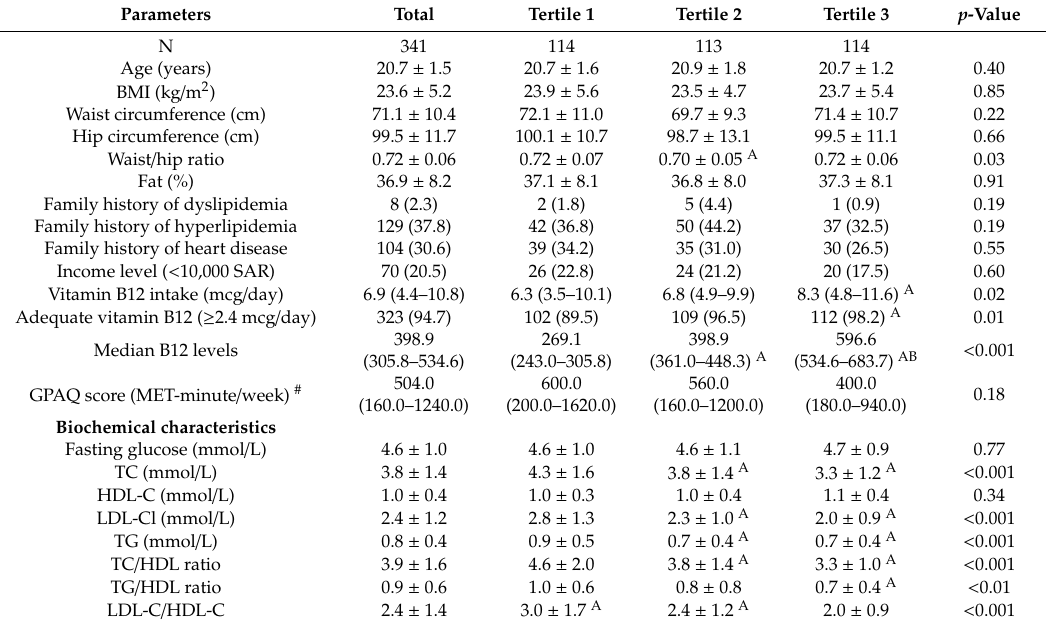
Table 1. Characteristics of study participants according to vitamin B12 tertiles.